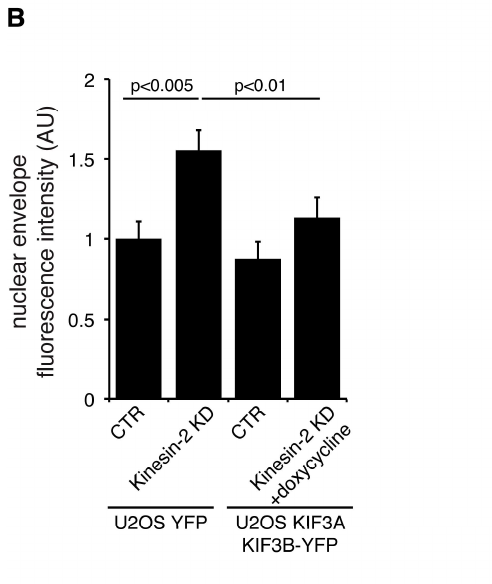
Figure 5. Defective lamina disassembly in Kinesin-2 KD cells is rescued by expression of silencing-resistant KIF3A and KIF3B. U2OS cells stably expressing the YFP empty vector (U2OS YFP) or the silencing-resistant KIF3A and KIF3B-YFP mutants (U2OS KIF3A KIF3B-YFP), indicated on the left, were silenced with control oligo (CTR) or with KIF3A and KIF3B oligos (Kinesin-2 KD). Expression of the silencing-resistant KIF3A mutant in the KIF3B-YFP cells was achieved by doxycycline treatment for 72 h. ( A ) Representative confocal images show epifluorescence of YFP or YFP-KIF3B in green, anti-lamin B1 antibody staining in red, and nuclei stained with DRAQ5 (in gray). ( B ) Quantification of lamin B1 staining in the samples treated as in ( A ) bar graph represents mean values ± SEM normalized over control, from three independent experiments, n = 15 cells/condition. ( C ) Total cellular lysates from cells treated as in A were immunoblotted as shown on the right (the band corresponding to KIF3B-YFP is also indicated).